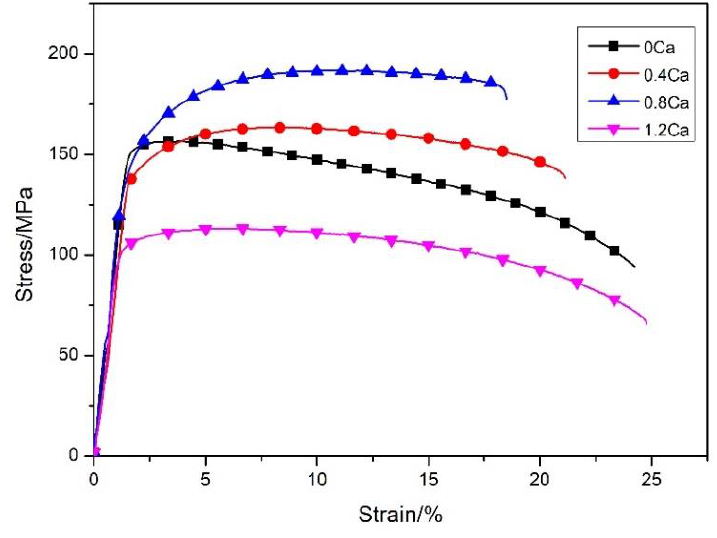
Figure 6. Stress–strain curves of extruded Mg–7Li–3Al–xCa alloys at 423 K (150 °C). Table 4. Mechanical properties of the extruded Mg–7Li–3Al–xCa alloys at 423 K (150 °C). Extruded Alloys